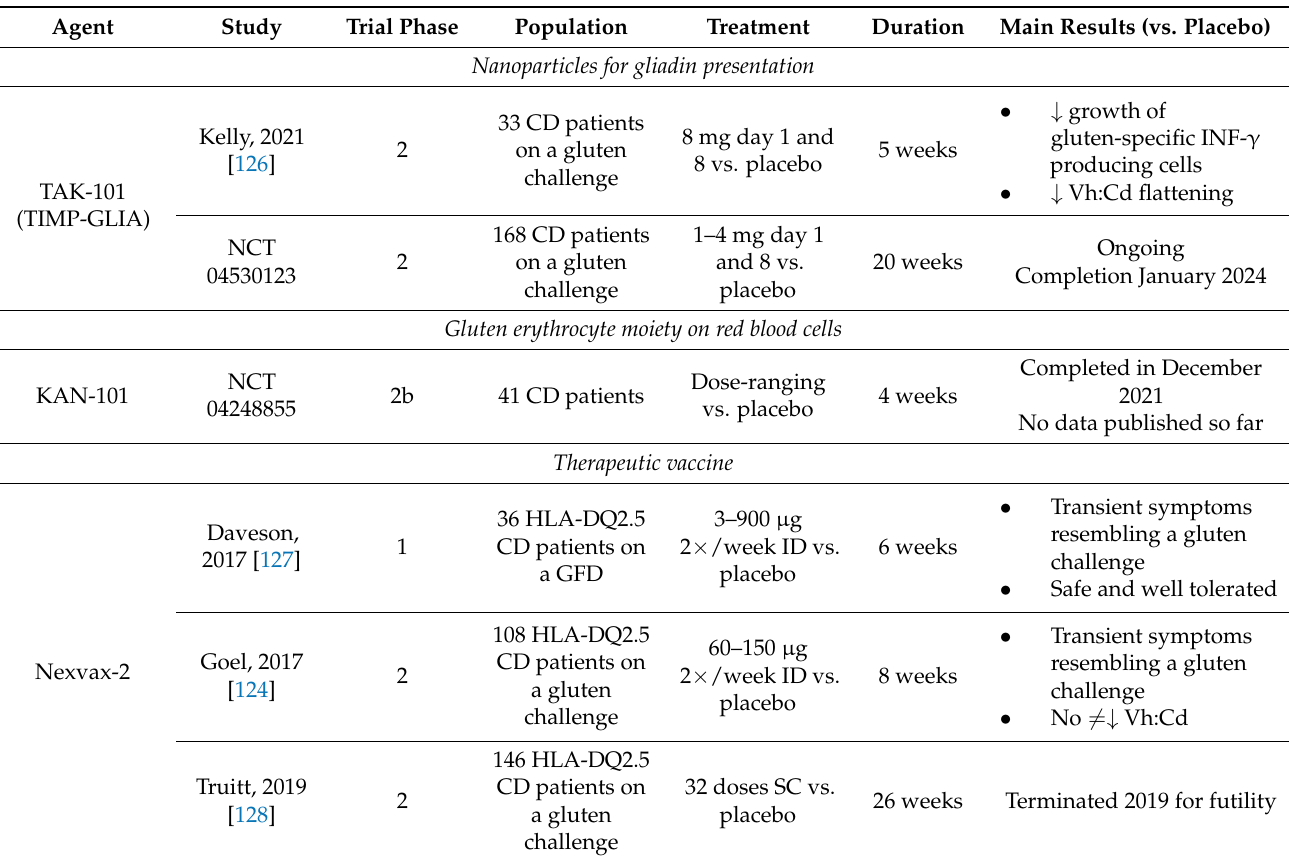
Table 3. Relevant clinical trials on agents that induce immune